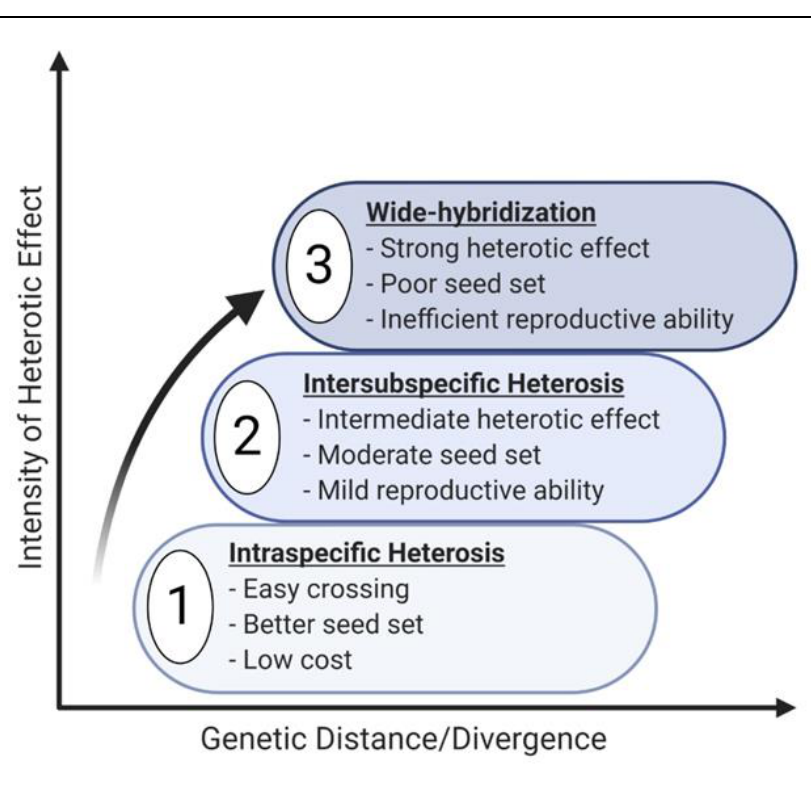
Figure 1. Classification of heterosis in plant breeding based on genetic distance and utilization.